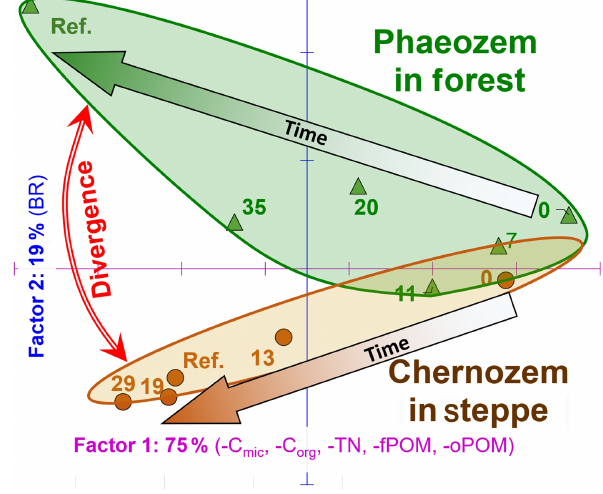
Figure 4. Example of the divergence of soil properties of abandoned agriculturally used Chernozem (under steppe) and Phaeozem (under forest) after termination of cultivation (Ovsepyan et al., 2019, mod- ified). The soil properties were analysed by principal component analysis (PCA). The soils had very similar properties due to long- term ( > 100 years) cropping (time point “0”). After abandonment, they started to develop to their natural analogues (Ref.: natural ref- erence soils), leading to strong divergences of their properties. This figure reflects the divergence by natural pedogenesis, i.e. the oppo- site situation to agropedogenesis. Numbers close to points: duration of abandonment, 0, is agricultural soil, and Ref. is natural analogues (never cultivated under natural vegetation). The soil parameters pri- marily driving the divergence are on the x axis: microbial biomass C (C mic ), soil organic C (C org ), total N (TN), free particulate organic matter (fPOM) and occluded organic matter (oPOM). On the y axis is basal respiration (BR). For details, see Ovsepyan et al.,